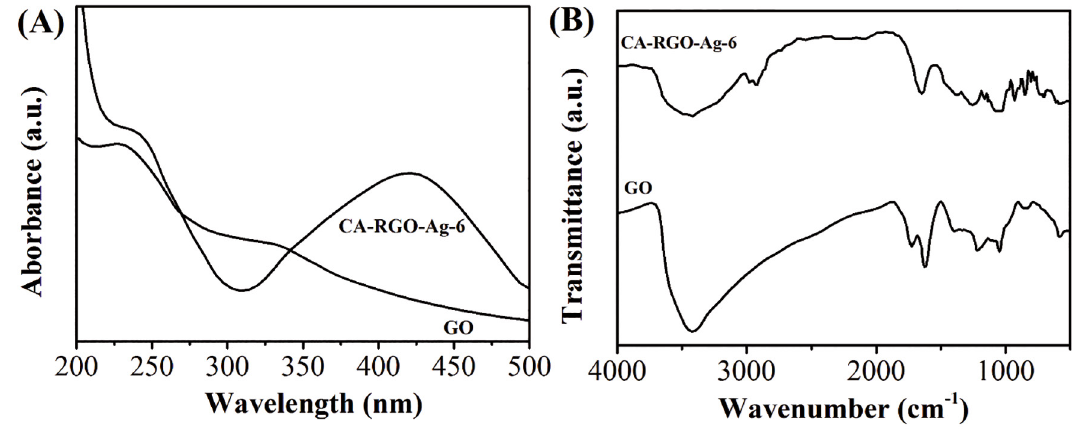
Figure 1: (A) UV-vis and (B) FTIR spectra of GO and CA-RGO-Ag-6.